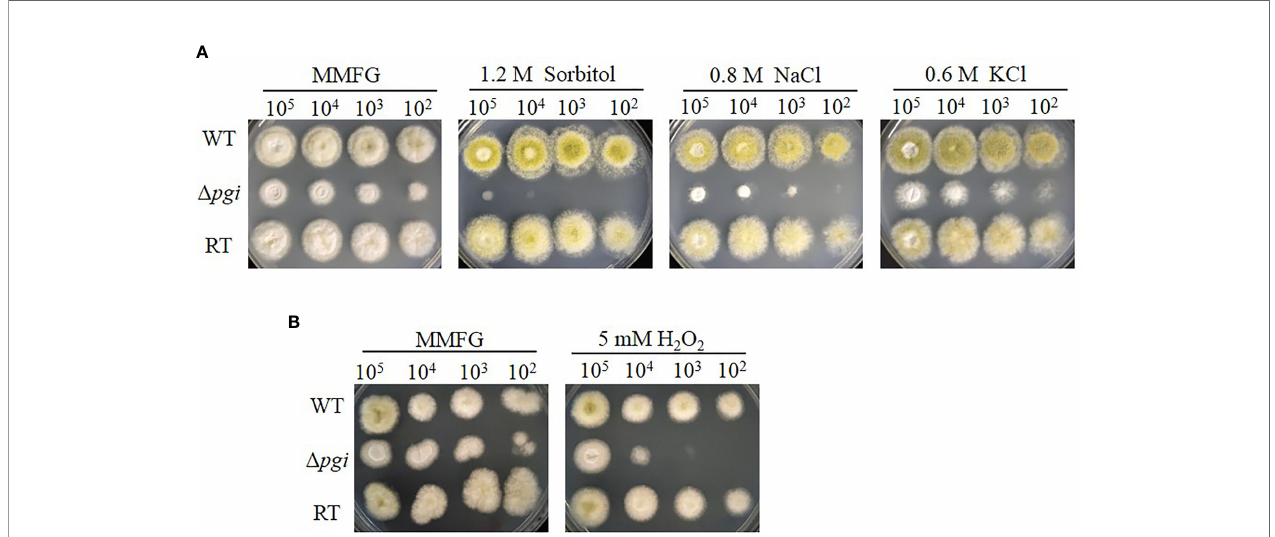
FIGURE 6 | Responses of the D pgi mutant to osmotic or oxidative stresses. 10 2 – 10 5 conidia of the WT, D pgi , and RT strains were cultured on MMFG medium supplemented with 1.2 M sorbitol, 0.8 M NaCl, 0.6 M KCl (A) , and 5 mM H 2 O 2 (B) and cultured at 37°C for 2 days.